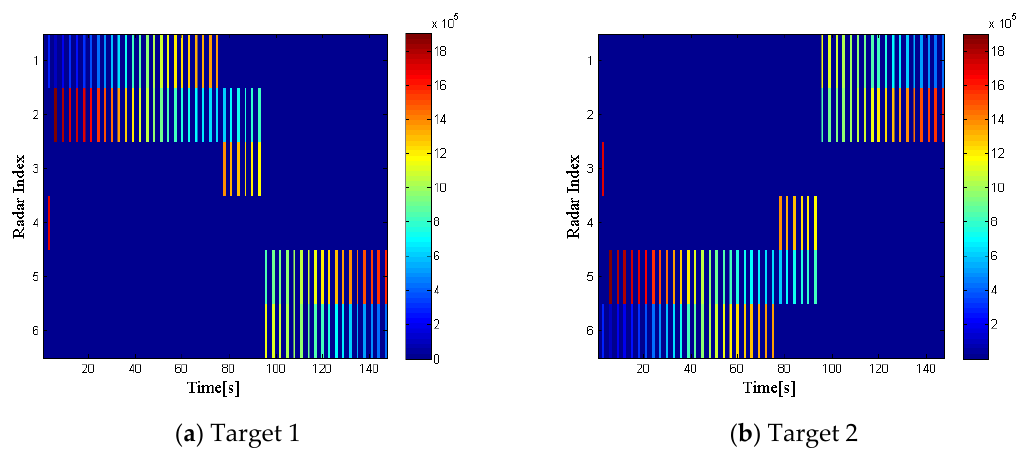
Figure 3. Radar selection and bandwidth allocation in radar cross section (RCS) case 1.